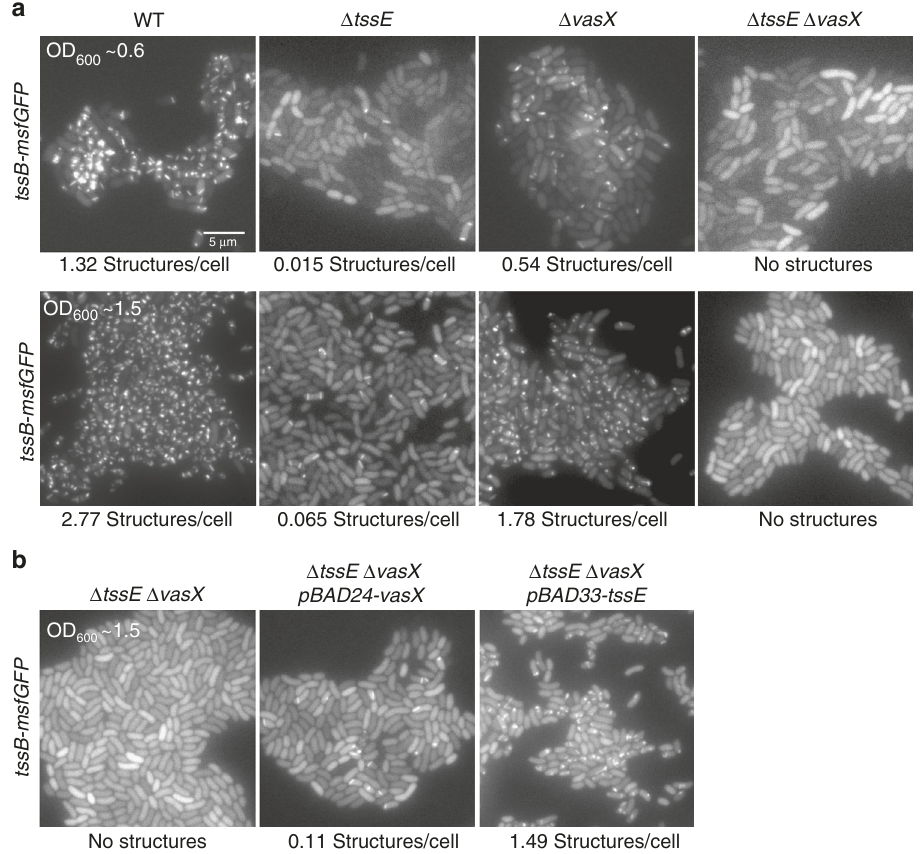
Fig. 5 TssE and VasX contribute to the regulation of T6SS assembly. a The sheath assembly was monitored by TssB-msfGFP localization in the absence of TssE, VasX, or both. Representative images of GFP channel are shown for each indicated strain (all tssB-msfGFP background). The upper panel shows the cells grown to OD 600 0.6; the lower panel shows the cells grown to OD 600 1.5. The average number of sheaths is indicated below each image. Time-lapse movies with a larger fi eld of view can be found in Supplementary Movies 3 and 4. b The sheath assembly was monitored by TssB-msfGFP localization with either tssE or vasX expressed under arabinose promoter in tssB-msfGFP strains lacking both tssE and vasX . The average number of sheaths is indicated below each image. Scale bar: 5 µ m. Time-lapse movies with a larger fi eld of view can be found in Supplementary Movie 5. Source data are provided as a Source Data fi